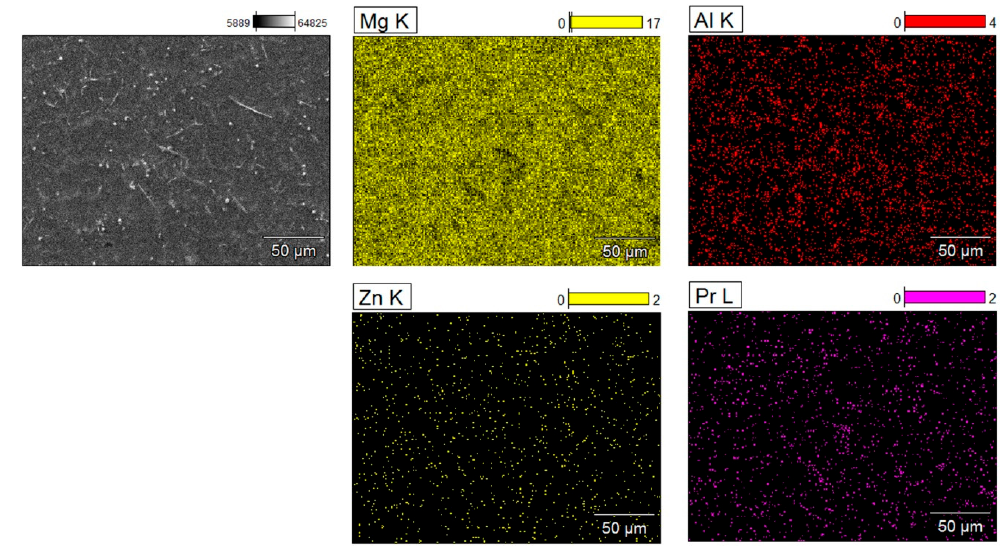
Figure 3. X-ray elemental map of Mg, Al, Zn and Pr of the surface of AZ91-1.0%Pr